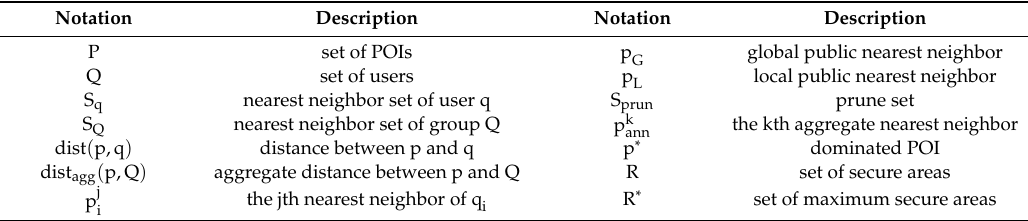
Figure 4. Details of our system architecture.